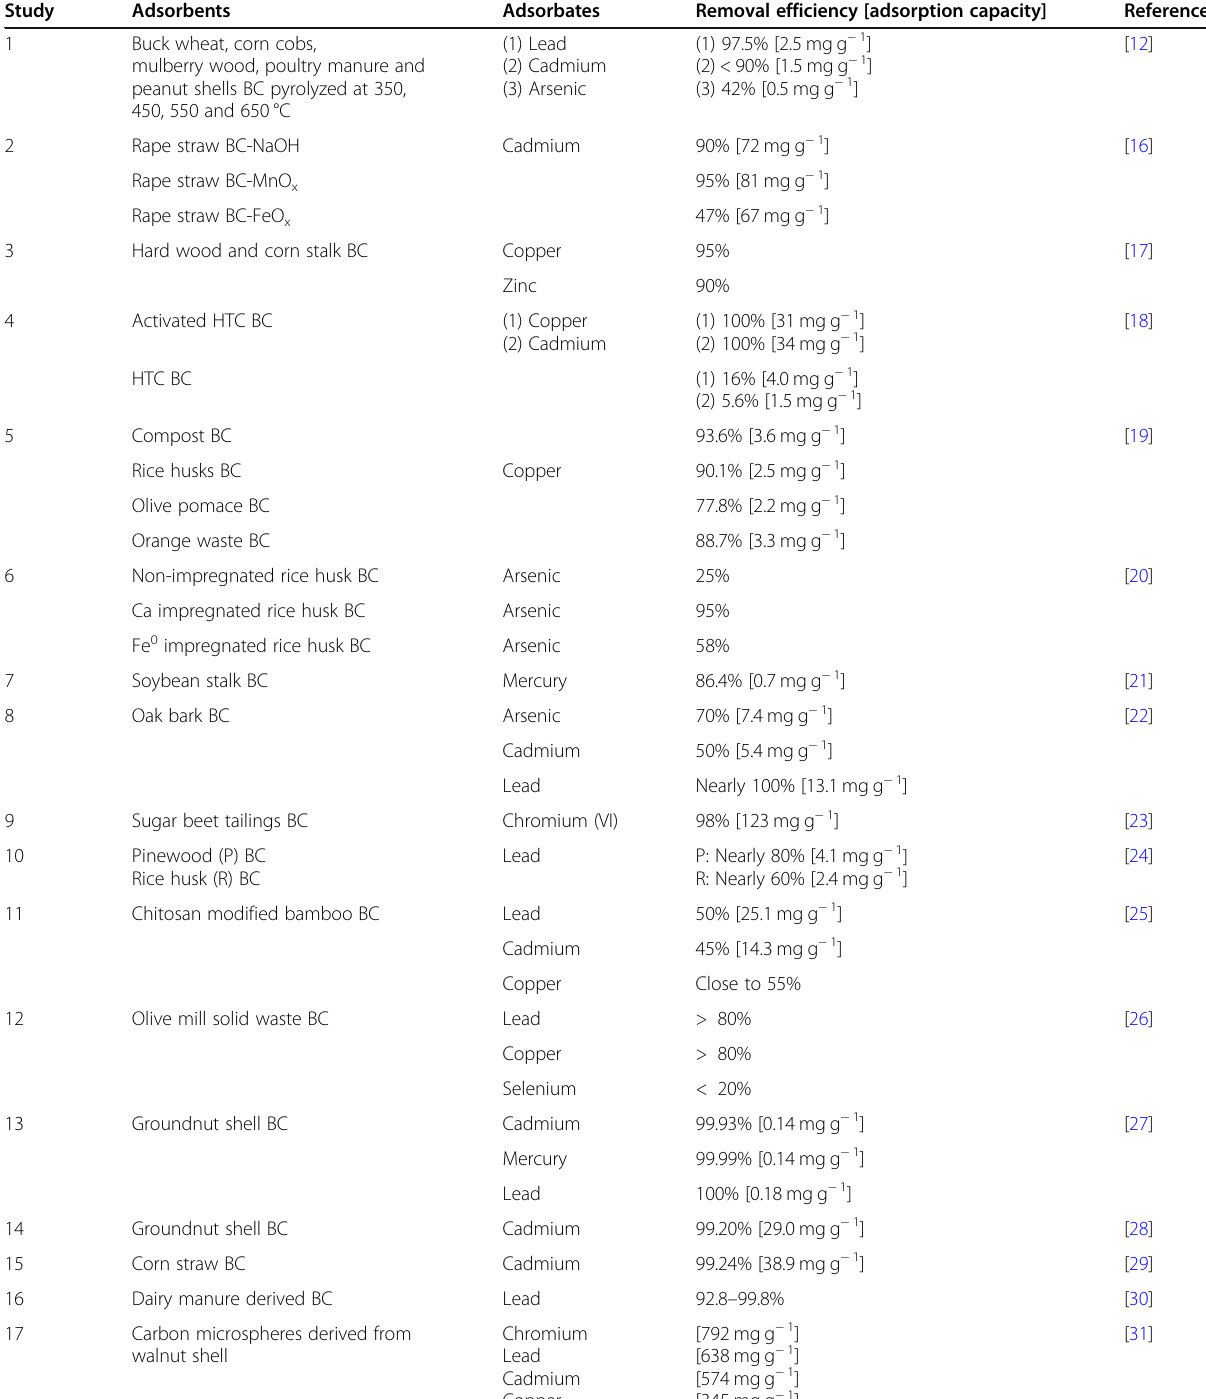
Table 1 Comparison of removal efficiencies [adsorption capacity] of various biochars Study